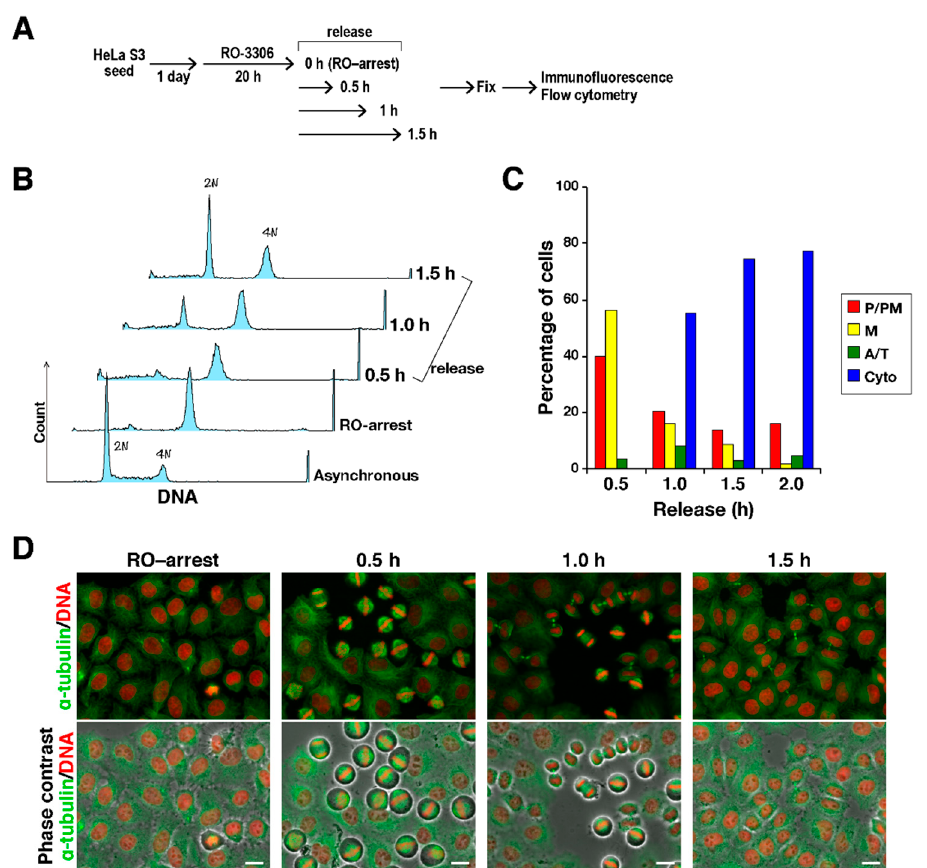
Figure 2. Cell cycle synchronization in M phase. Cells were treated with 6 µM RO-3306 for 20 h. After release from RO-3306 treatment, the cells were fixed at 0.5, 1, and 1.5 h after the release. ( A ) A schematic depiction of the experiment is shown. ( B ) Cells were stained for DNA with propidium iodide, and DNA content was measured by a flow cytometer. Each curve represents 5000 cells. Peak haploid genome equivalents (2N, 4N) are indicated. ( C ) On the basis of α -tubulin and DNA morphologies under a microscope, the M phase cells were classified into four groups: prophase/prometaphase (P/PM), metaphase (M), anaphase/telophase (A/T), and cytokinesis (Cyto). The percentages of cells in each group are plotted ( n > 204). ( D ) Representative images are shown; α -tubulin (green), DNA (red). Scale bars, 20 µm.